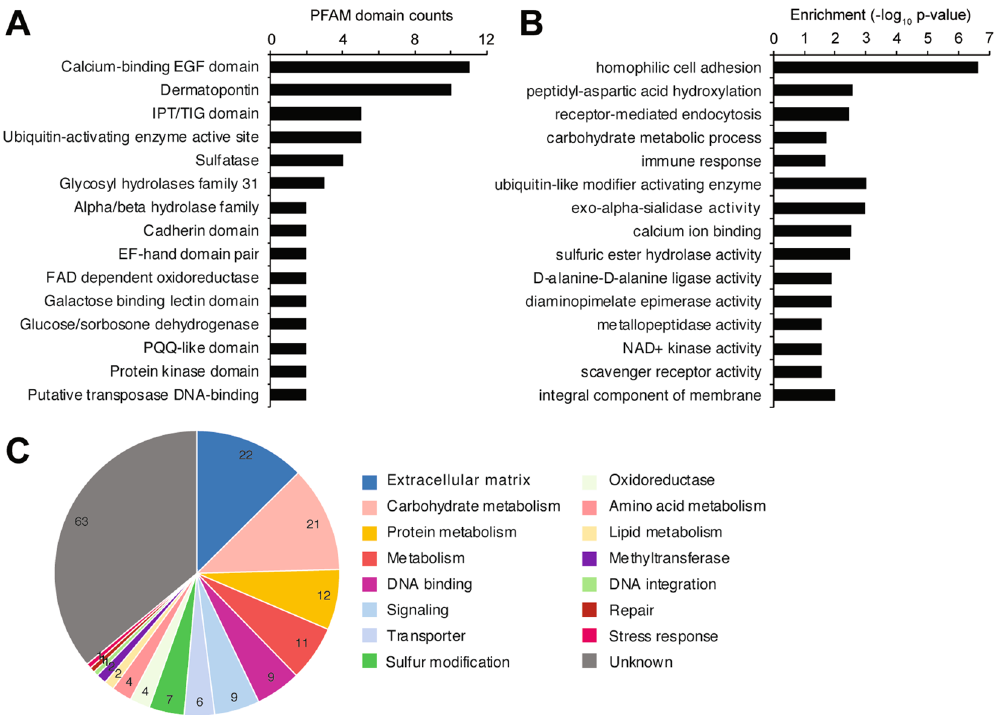
Figure 4. Functional analysis of candidate HGTs. ( A ) Most common PFAM protein domains in the set of candidate HGTs. ( B ) Gene ontology functions enriched in the set of putative HGTs. Enrichment p-values ( p ≤ 0.05) for selected functions are shown. ( C ) Number of candidate HGTs with associated functions based on manual